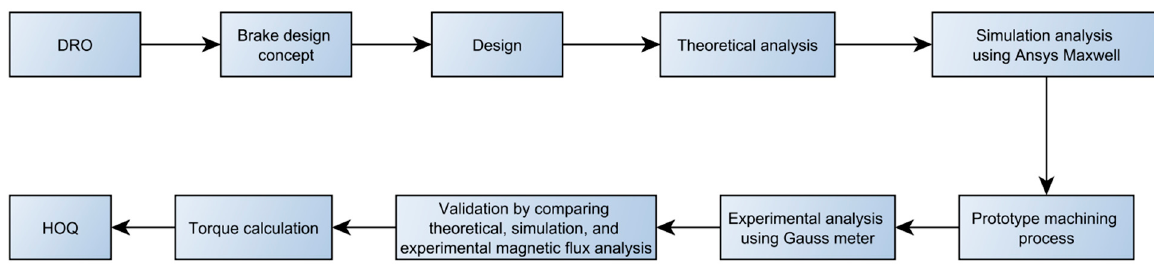
Figure 1. The flow chart for design and analysis of TVMRB.